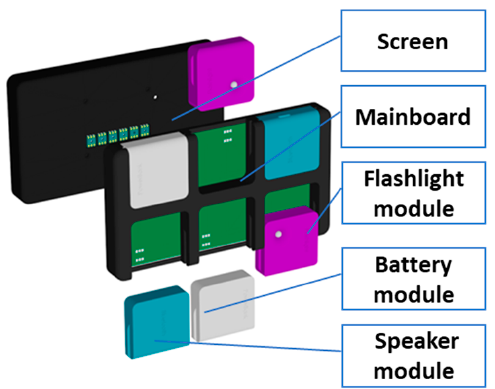
Figure 3. Example of tablet configuration as final product.